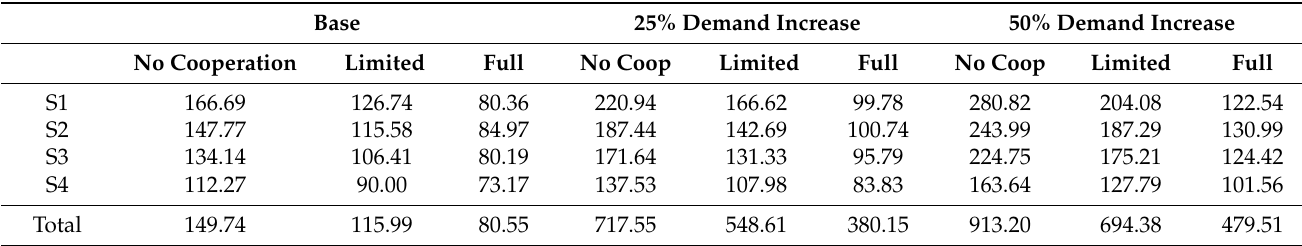
Table 6. Average lead times (minutes) in the 100 replications for non-, limited, and full cooperation settings for each supermarket by demand increase